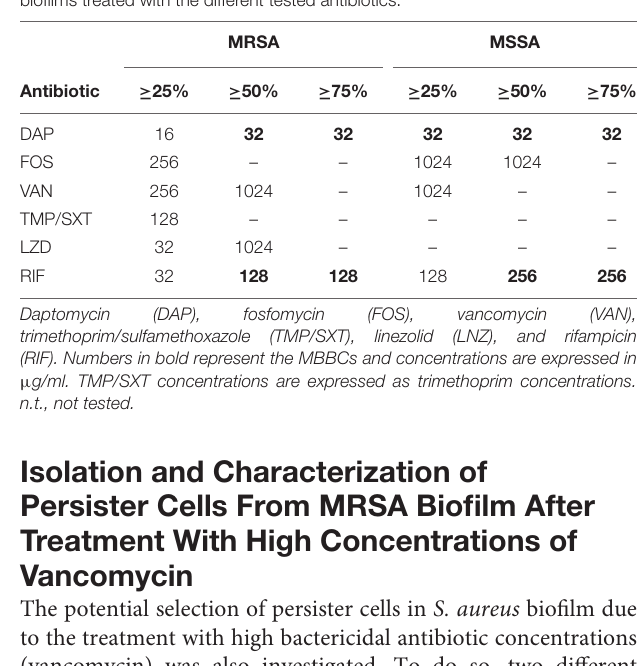
TABLE 2 | Percentage of reduction in heat (J) produced by MRSA and MSSA biofilms treated with the different tested